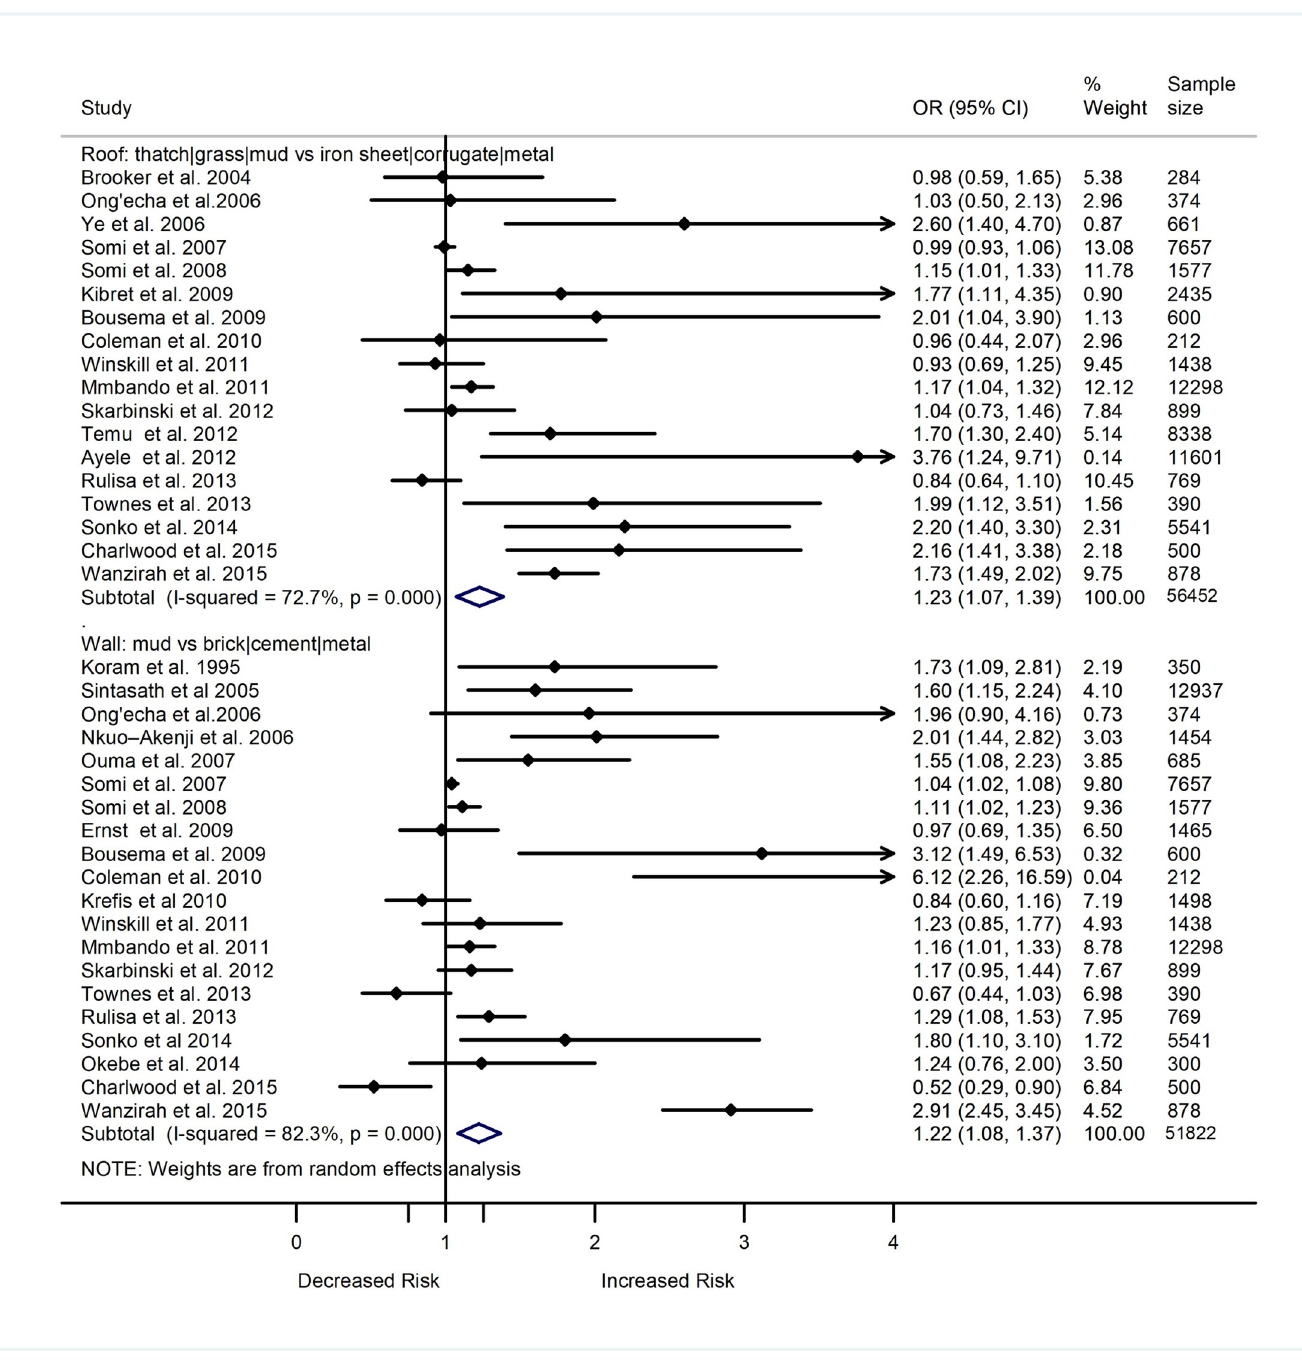
Fig 2. Forest plot showing the relationship of the roof and walls nature of a house with the epidemiology of malaria in sub-Saharan Africa. Values show the odds ratio of Plasmodium infection (95% CI). Subtotal (summary) ORs estimated using random effect models. Weights estimated using inverse variance method. I 2 , a measure of